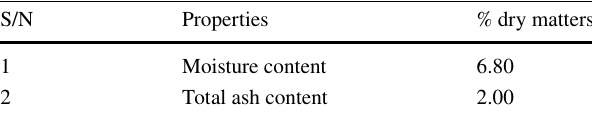
Table 1 Proximate analysis of the Tiger nut